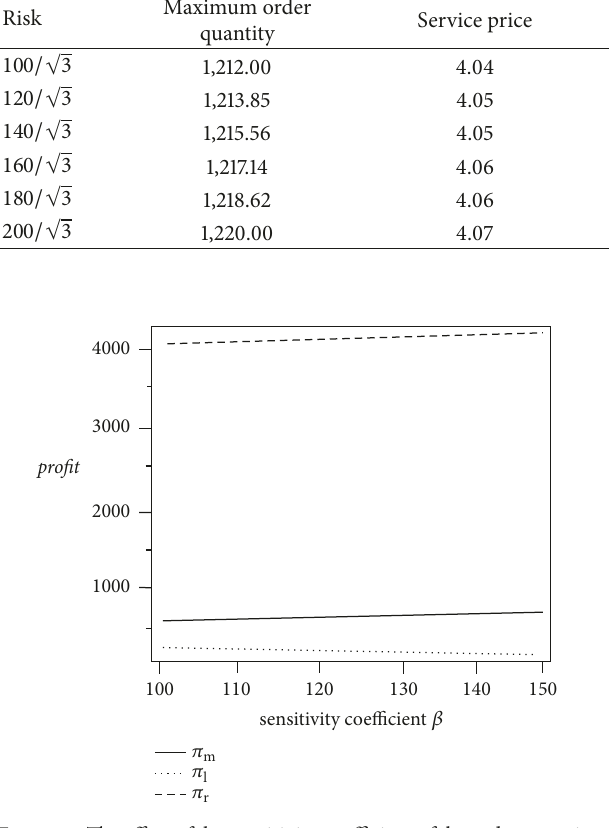
Figure6:Theeffectofthemarketriskparameteronthesupplychain members’